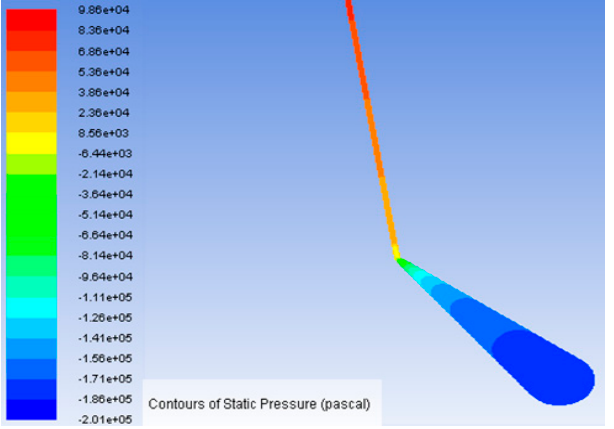
Figure 4. Contour of static pressure.